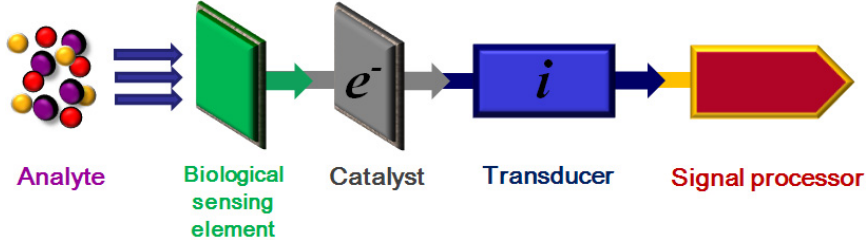
Figure 1. Generalized biosensor schematic showing stages in response to analyte.